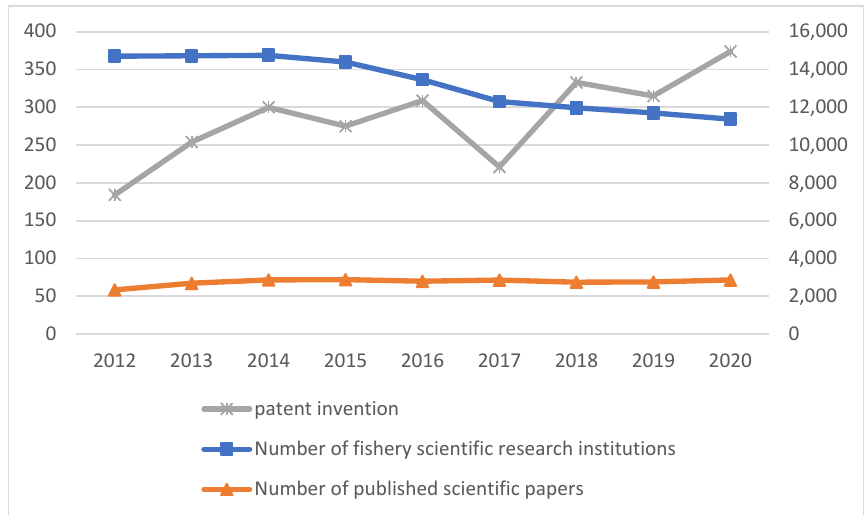
Figure 3. The number of scientific research institutions, the number of published papers and the changing trend of invention patents .